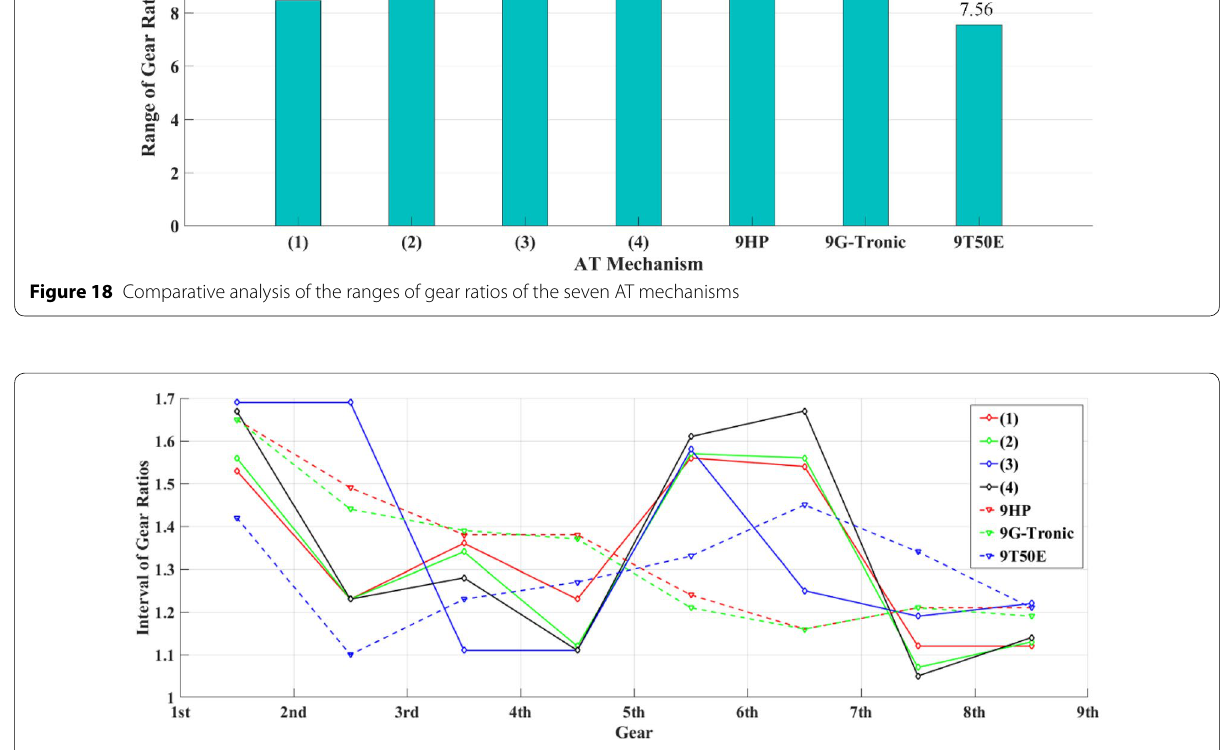
Figure 19 Comparative analysis of the intervals of gear ratios of the seven AT mechanisms